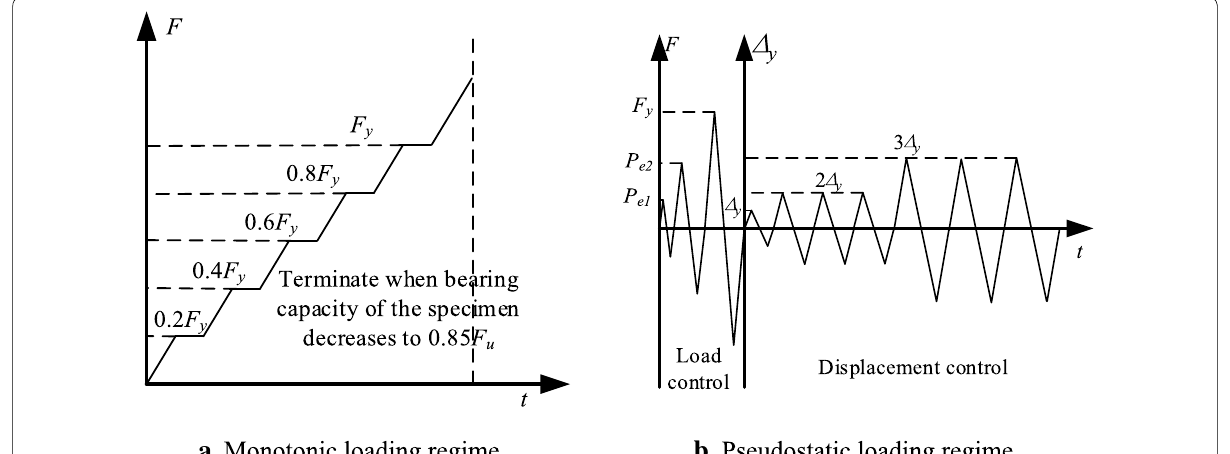
Fig. 5 Loading regimes.